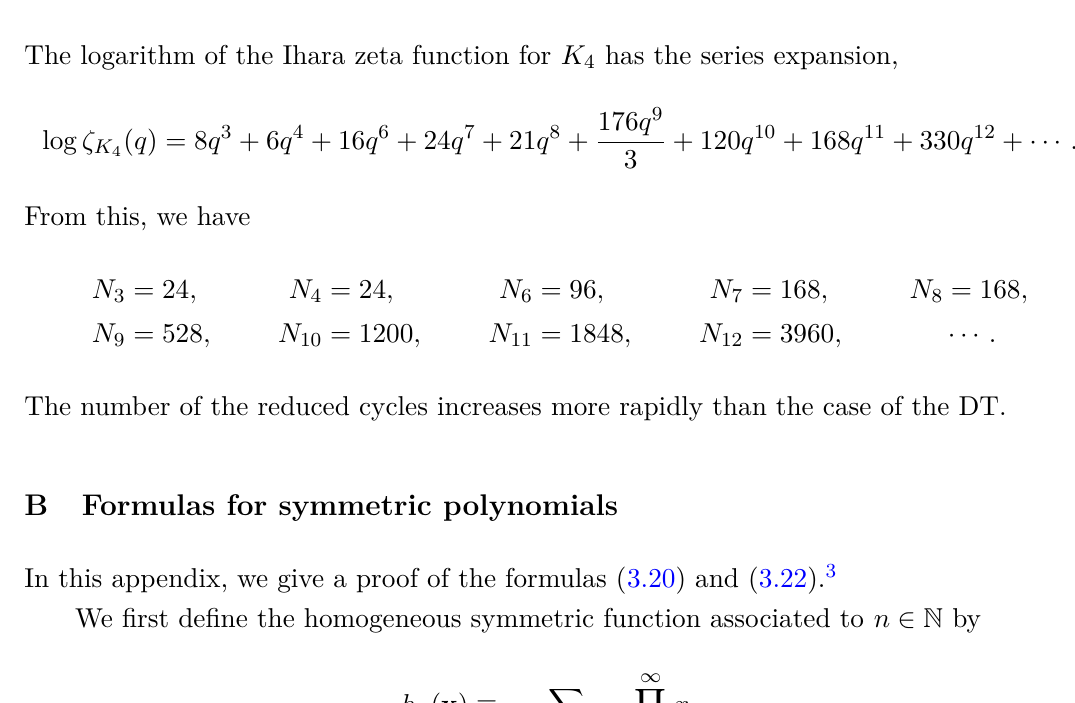
Figure 5. This graph has four vertices and six edges and forms a tetrahedron, where four triangles are gluing with each other. The three-dimensional tetrahedron graph is equivalent to a planner complete graph K 4 , since the graph has only the information on the connections between